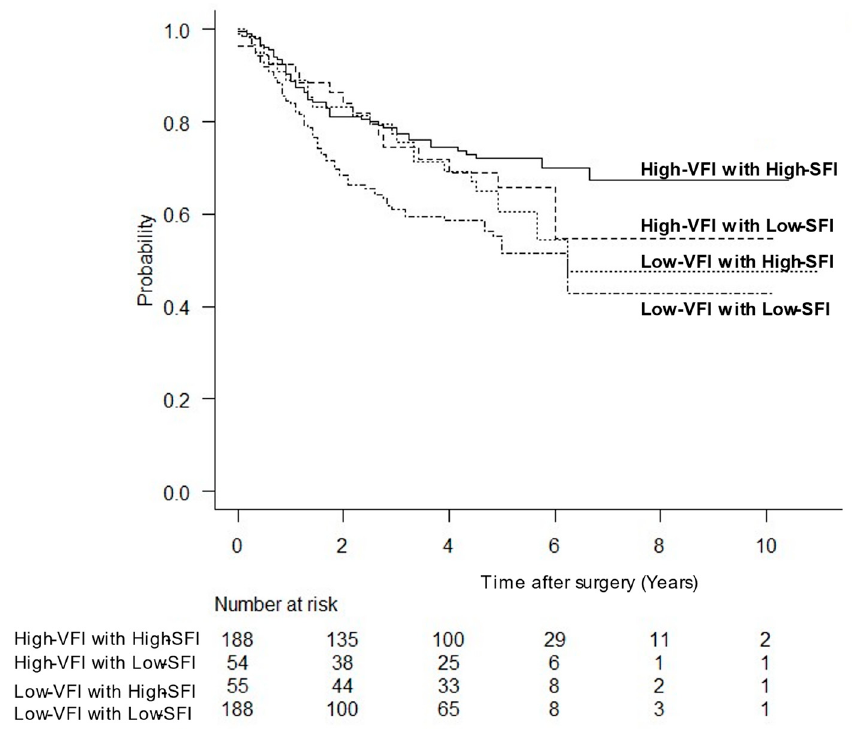
Figure 3. Kaplan–Meier survival curves for overall survival stratified by visceral fat and subcutaneous fat masses.